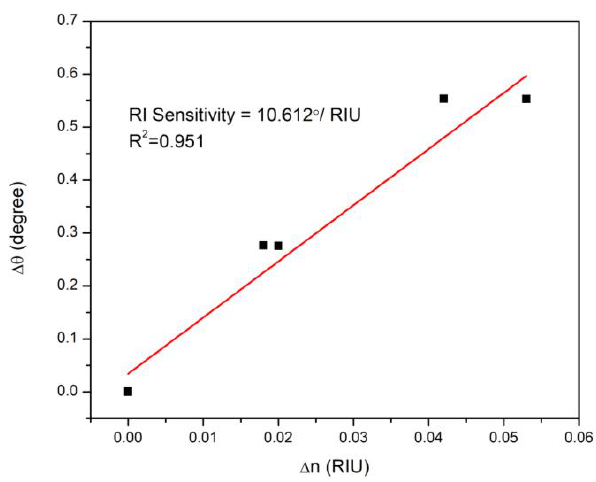
Figure 7. Linear fitting of the change in resonance angle versus the change in the sensor film refractive index exposed to gradually increasing doses of DA.